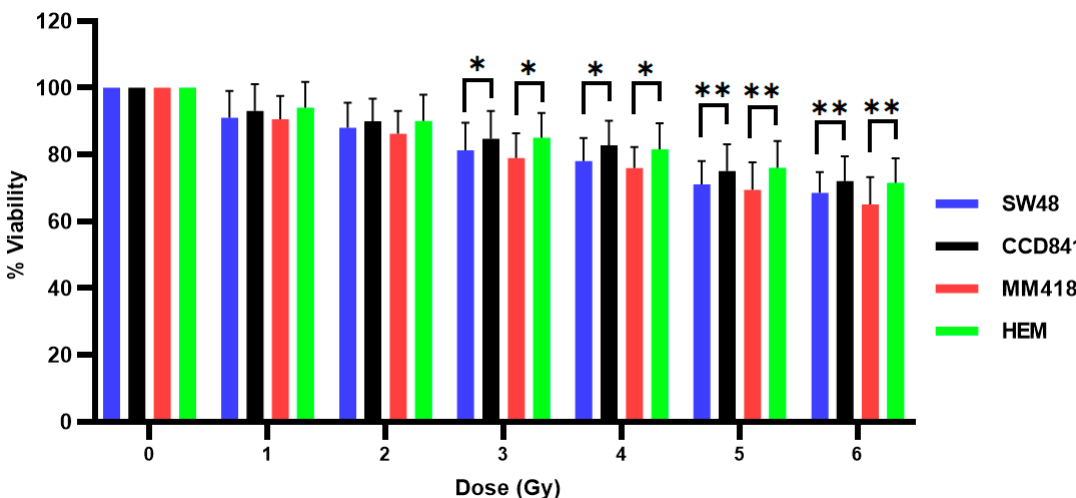
Figure 4. Effect of AuNPs + IR on the viability of human colon adenocarcinoma (SW48) and melanoma (MM418-C1) cell lines compared to their non-cancerous counterparts (CCD841 and HEM cells). The cells were treated with 1 mM AuNPs for 24 h prior to being exposed to 0–6 Gy of 6 MV X-rays. Cell viability (% viability) was measured 48 h post-irradiation using the MTS assay. Results are expressed as the mean ± SEM of 3 replicates. Significance of different treatments compared to control is represented by black lines shown as * p < 0.05 and ** p < 0.01.